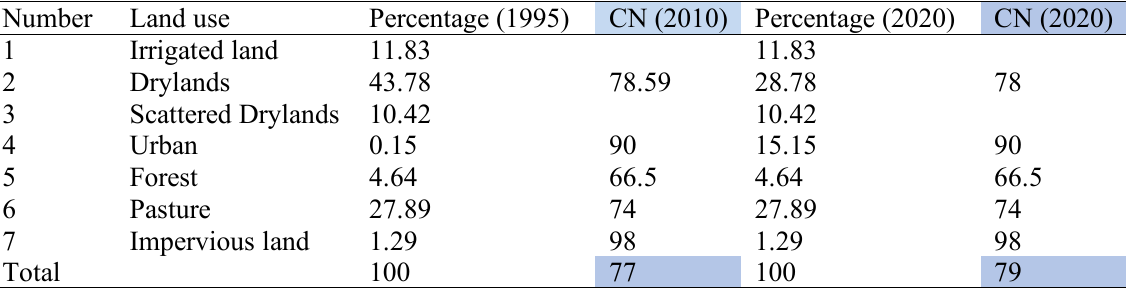
Table 5. Land use distribution in the Ilam